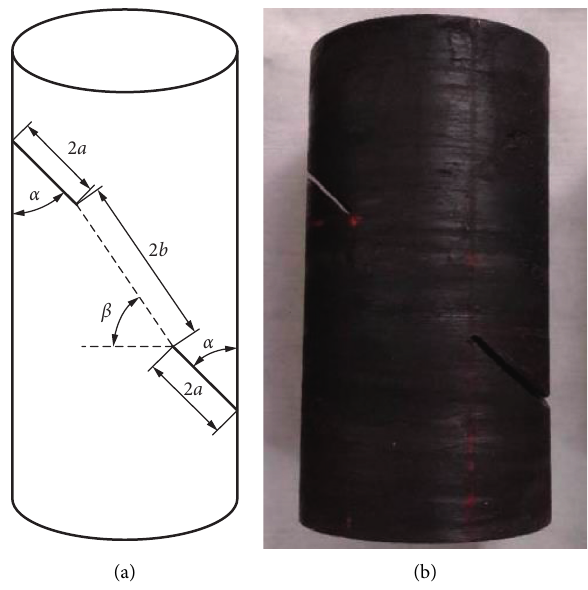
Figure 1: Geometry of the marble specimen with preexisting fissure.